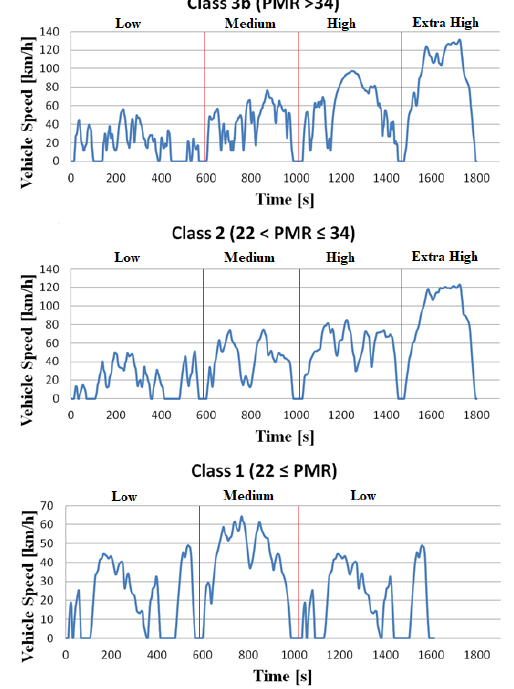
Fig. 1. Speed vs. time traces of the WLTC driving cycle for all vehicle classes